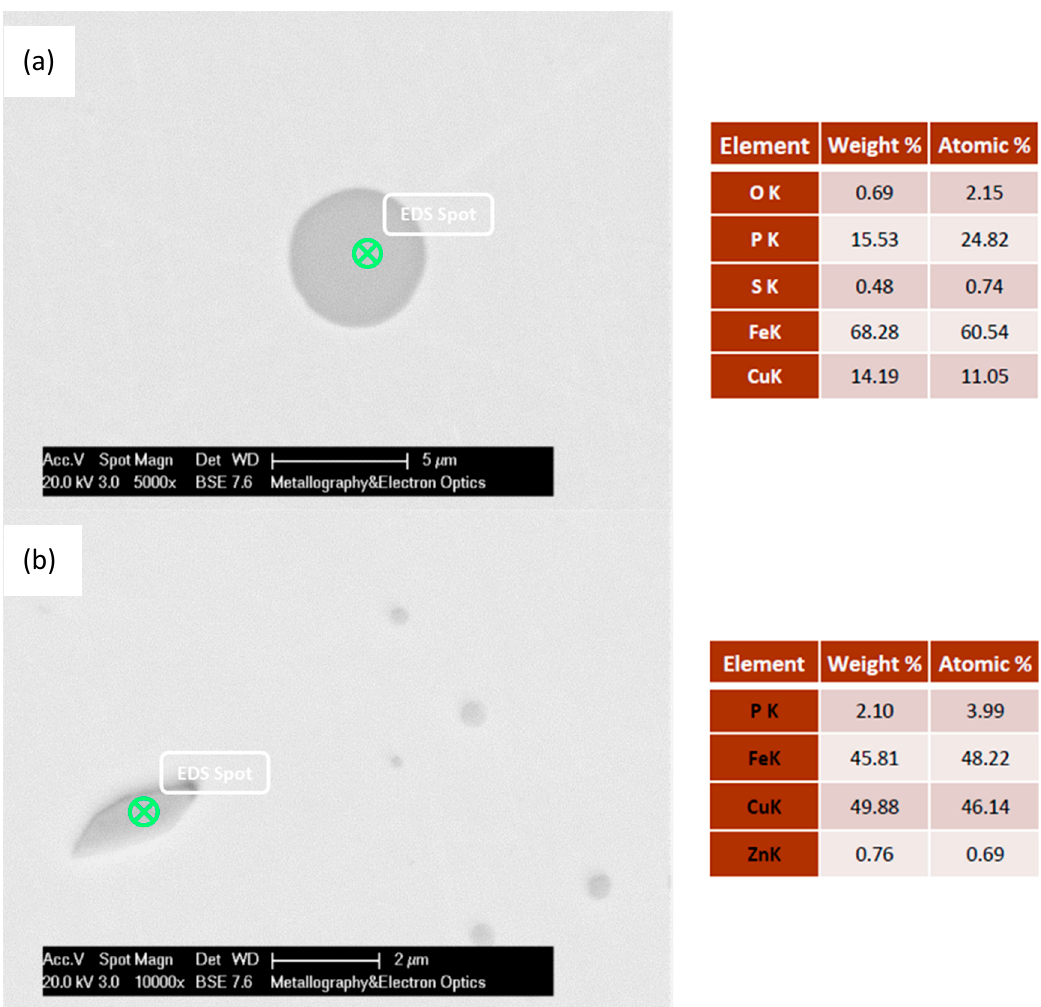
Figure 10. Scanning electron microscopy–energy dispersive X-ray spectroscopy (SEM–EDS) analysis on the intermetallic particles ( a ) spherical Fe 3 P particle, ( b ) elliptical Fe enriched particle. The arrow indicates where the chemical analysis was taken.